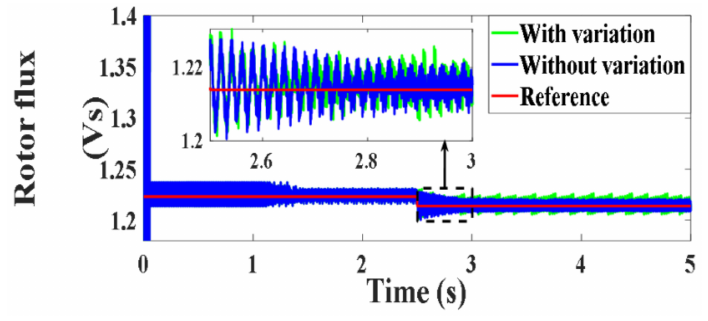
Figure 112. Rotor flux under PVC